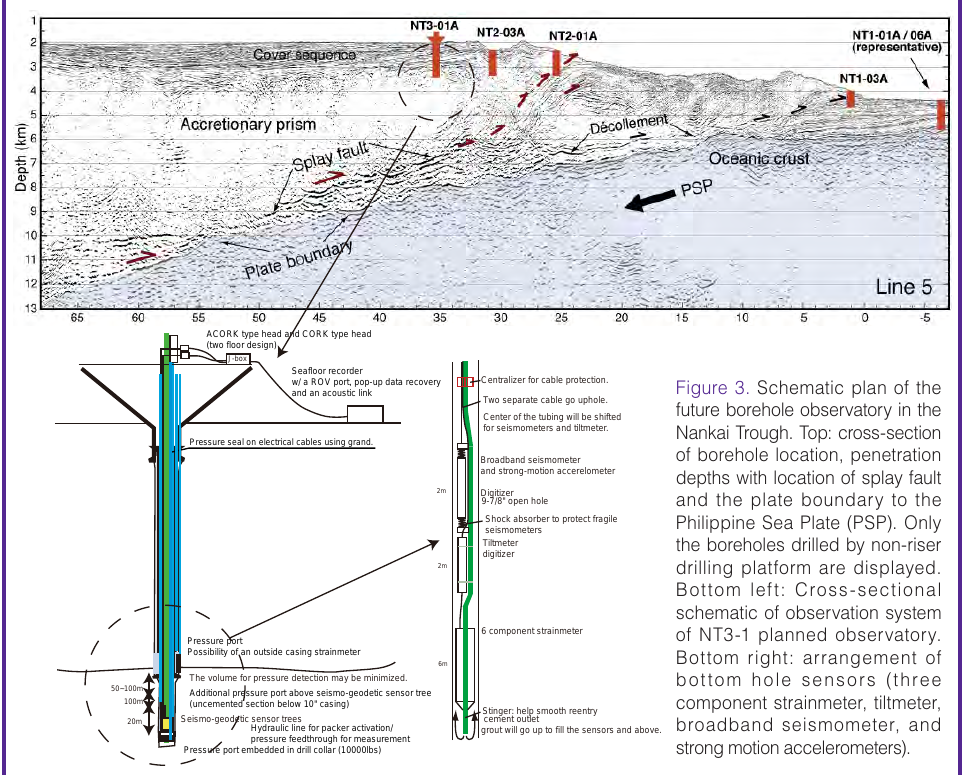
Figure 3. Schematic plan of the future borehole observatory in the Nankai Trough. Top: cross-section of borehole location, penetration depths with location of splay fault and the plate boundary to the Philippine Sea Plate (PSP). Only the boreholes drilled by non-riser drilling platform are displayed. Bottom left: Cross-sectional schematic of observation system of NT3-1 planned observatory. Bottom right: arrangement of bottom hole sensors (three component strainmeter, tiltmeter, broadband seismometer, and strong motion